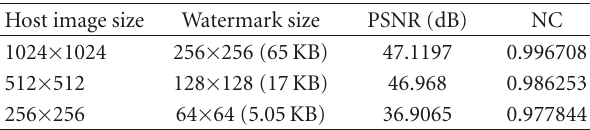
Table 3: Results of embedding data in Lena image with di ff erent